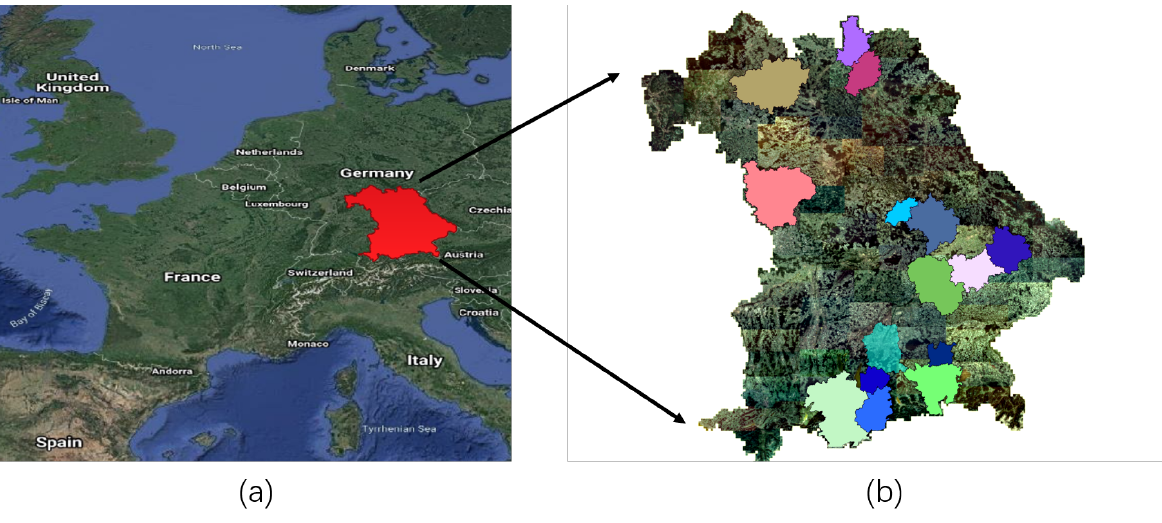
Figure 1. (a)The location of the state of Bavaria, Germany, (b) The study sites in this research which cover 15 districts in the state of Bavaria, Germany.